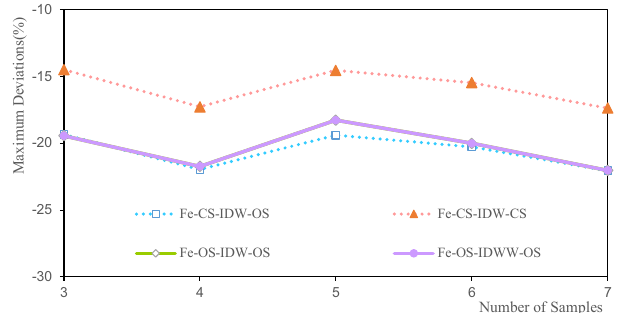
Figure 18. Deviation of the Fe maximum grade.